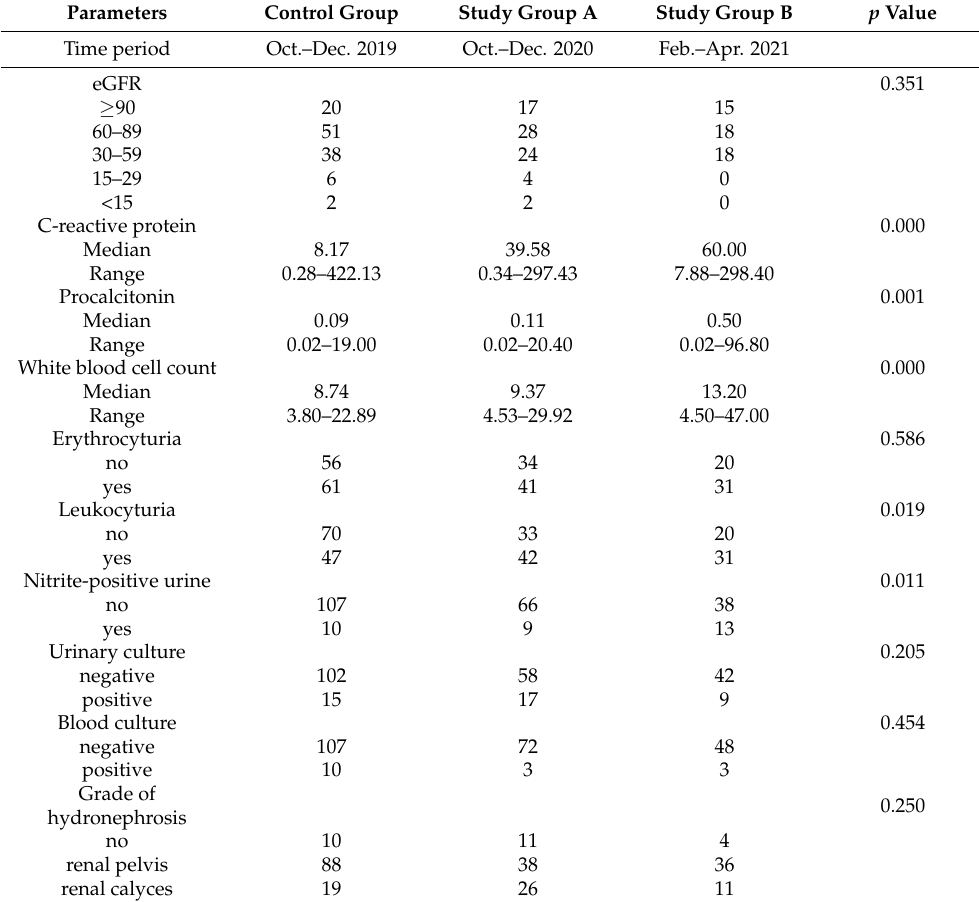
Table 2. Crucial laboratory parameters and imaging findings in patients admitted due to renal